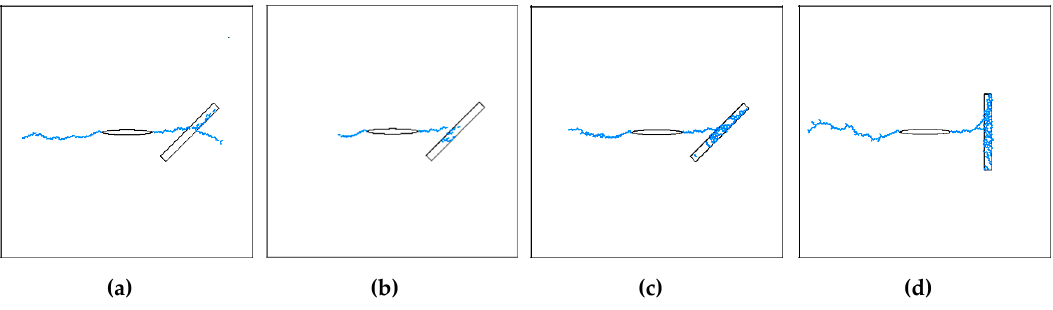
Figure 16. Four new interaction modes: ( a ) Group 4A at 45° and 10 MPa; ( b ) Group 4C at 45° and 11 MPa; ( c ) Group 4D at 45° and 11 MPa; and ( d ) Group 4D at 90° and 11 MPa.